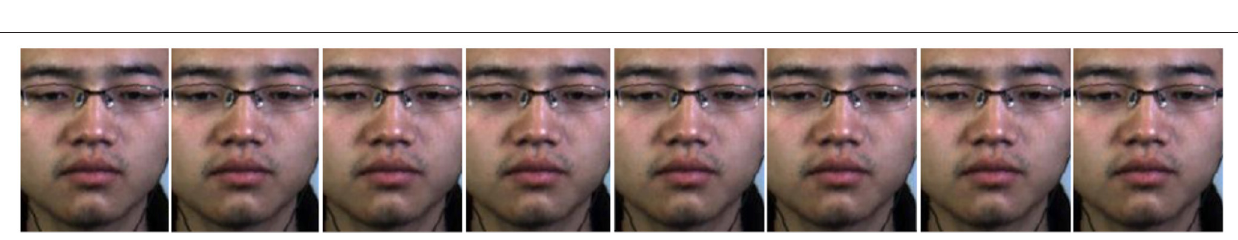
FIGURE 1 | Sample frames from a “Surprise” sequence (Subject 1) in SMIC. Images reproduced from the database with permission from Li et al. (2013).